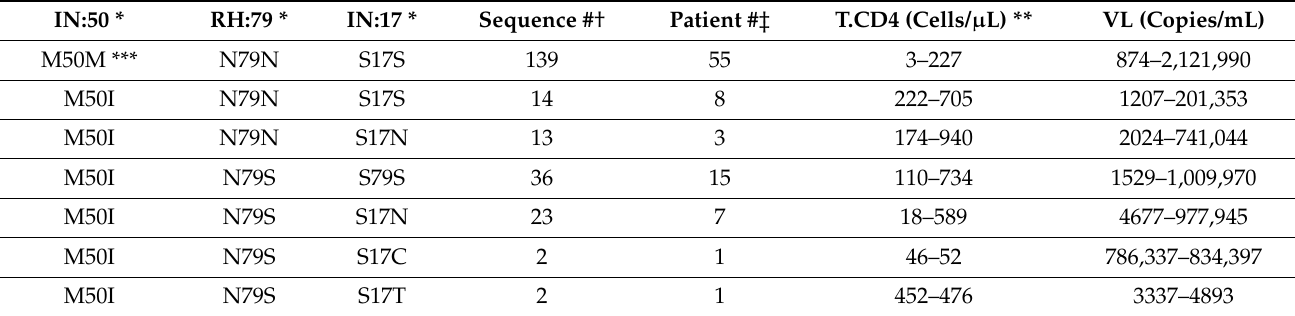
Table 1. A profile of CD4(+) T cell counts and VL among patients infected with HIV containing IN:M50I mutation. IN:50